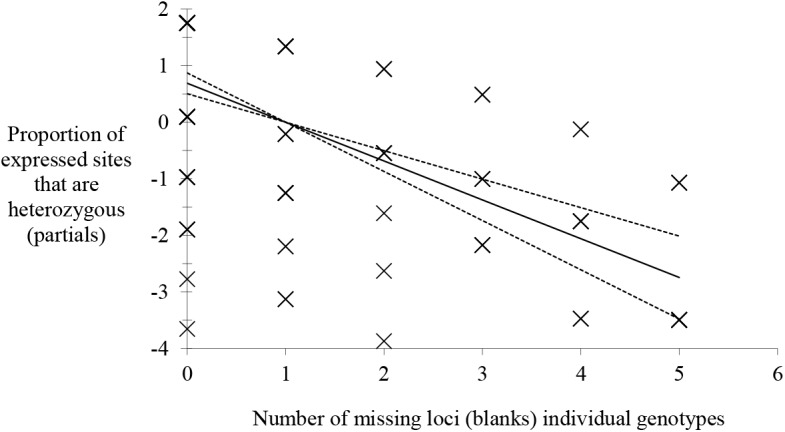
Results of the logistic regression between the proportions of heterozygous genotypes observed in Trypanosoma brucei gambiense from Guinea amplified from biological fluids and the number of amplification failures [28].The relationship has been tested with the chi2 test, which proved highly significant (p-value < 0.001). 95% confidence intervals are presented with dotted lines.